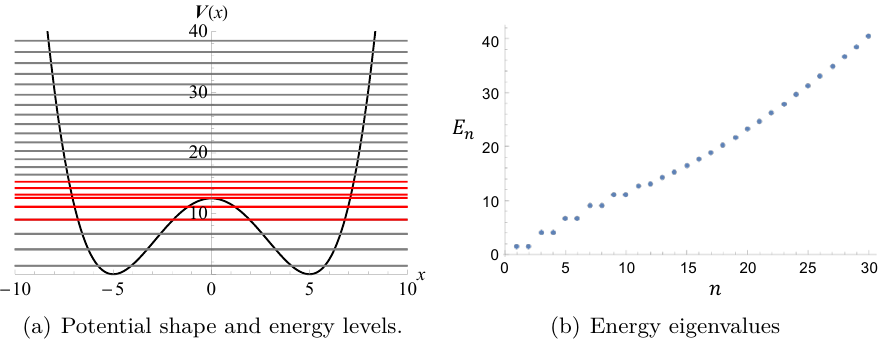
Figure 1 . Inverted harmonic oscillator potential for λ = 2 , g = 1 / 50 ( V (0) = 12 . 5 ) and its energy levels. The energy levels in red color play an important role for exponential growth of OTOCs. See figure 2. Note that the energy levels smaller than n = 11 are almost degenerated so the black lines below the top of the hill in (a) are double